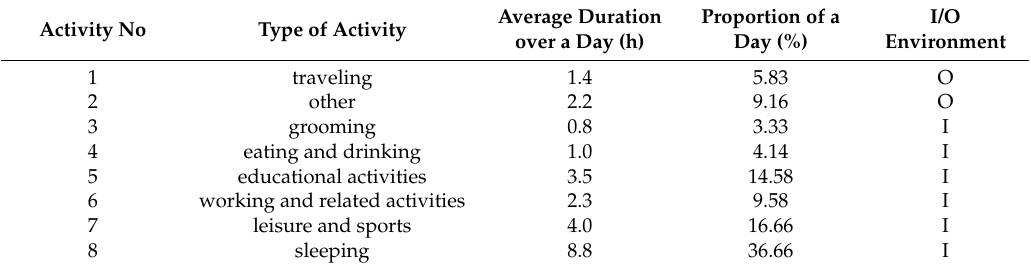
Table 1. Students’ activity characteristics